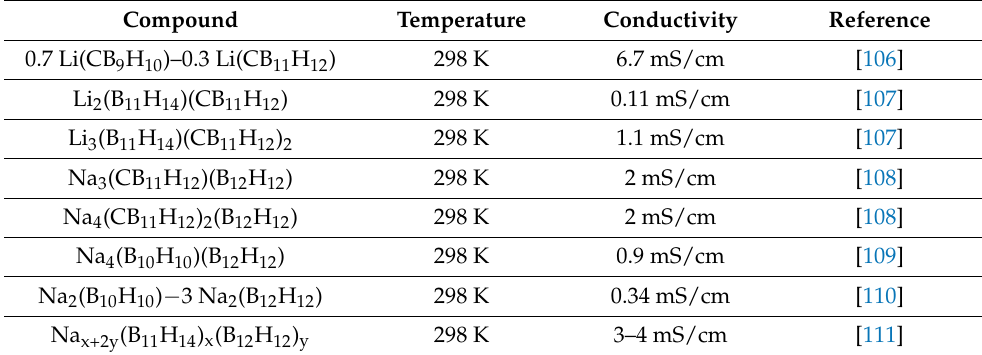
Table 1. Examples of ionic conductivity in mixed borate salts.